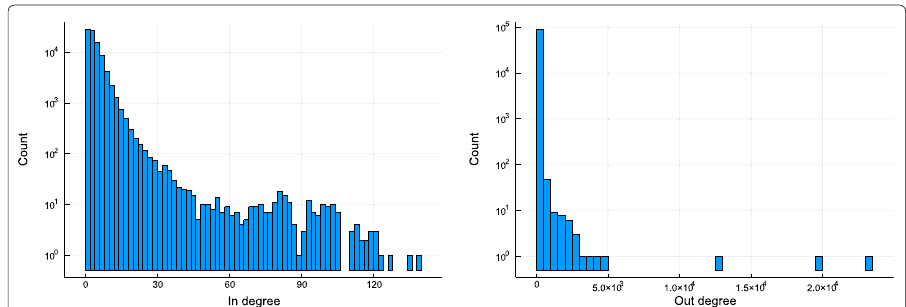
Fig. 7 Choosing the number of communities: Elm. Left: the mean pairwise adjusted mutual information of the community-node membership across repeated decompositions. 1 is a perfectly stable assignment to communities; 0 is perfectly random. The shaded area corresponds to twice the standard error of the mean. Right: the mean normalised residual sum of squares error for repeated decompositions on the Elm network against the number of components. The shaded area corresponds to twice the standard error of the mean above and below the